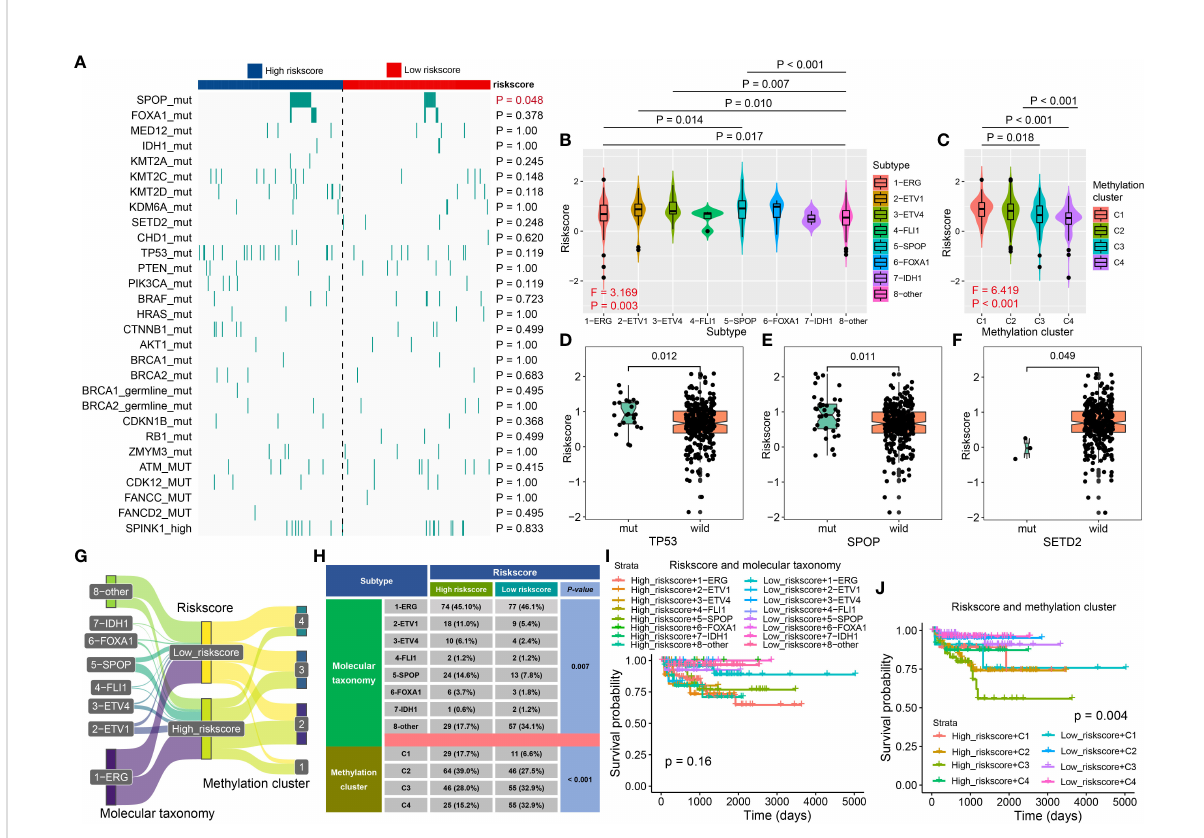
FIGURE 7 The association between CRPGS and SPOP, TP53, SETD2 mutation, and DNA methylation level. The heat map showed the distribution of SPOP mutation, FOXA1 mutation, IDH1 mutation, etc., between high- and low-risk PCa patients (A) . The distribution of riskscore in different molecular subtypes, DNA methylation clusters, TP53, SPOP, and SETD2 mutation (B – F) . Sanky plot showed the comparison results of CRPGS with molecular taxonomy (G) , and the c 2 test table showed the distribution of CRPGS in different molecular taxonomies (H) , and the combined effects of CRPGS + molecular taxonomy/methylation cluster on PCa patients ’ survival (I – J)